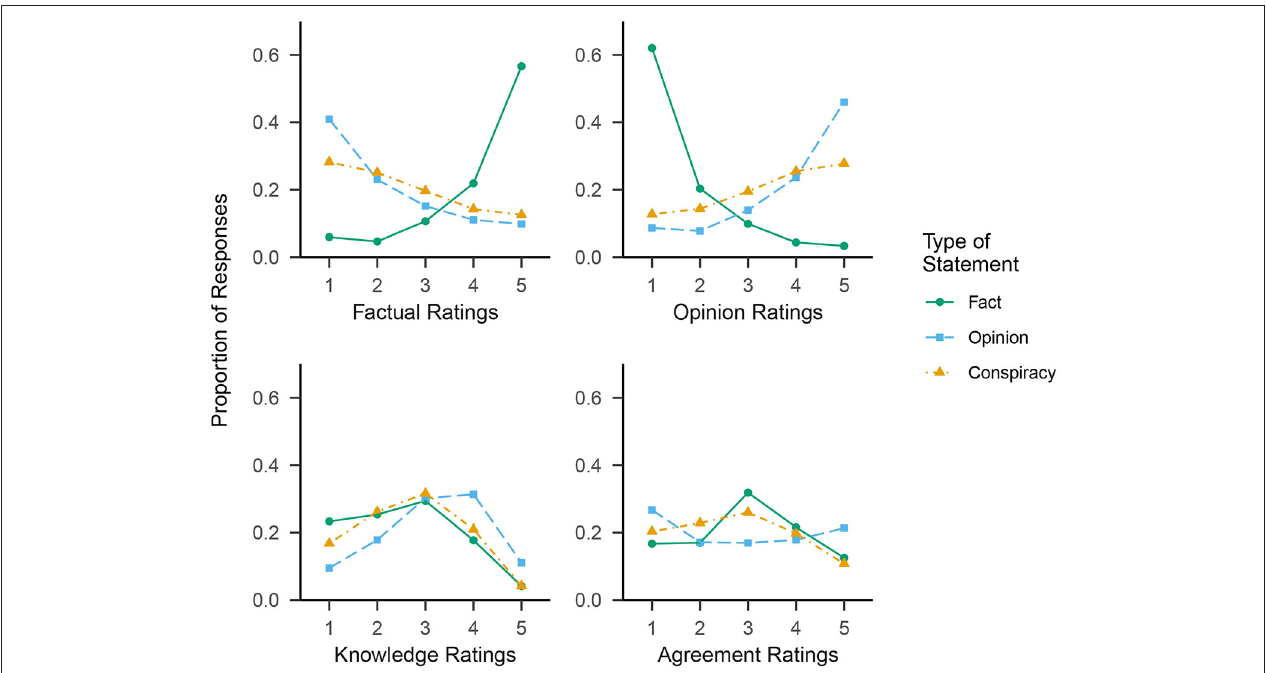
FIGURE 4 | Proportions of ratings at each point on the 5-point response scale to each of the Factual, Opinion, Knowledge, and Agreement rating scales in Study 2. The three separate lines in each panel represent the three different types of stimulus statement: Fact, Opinion, and